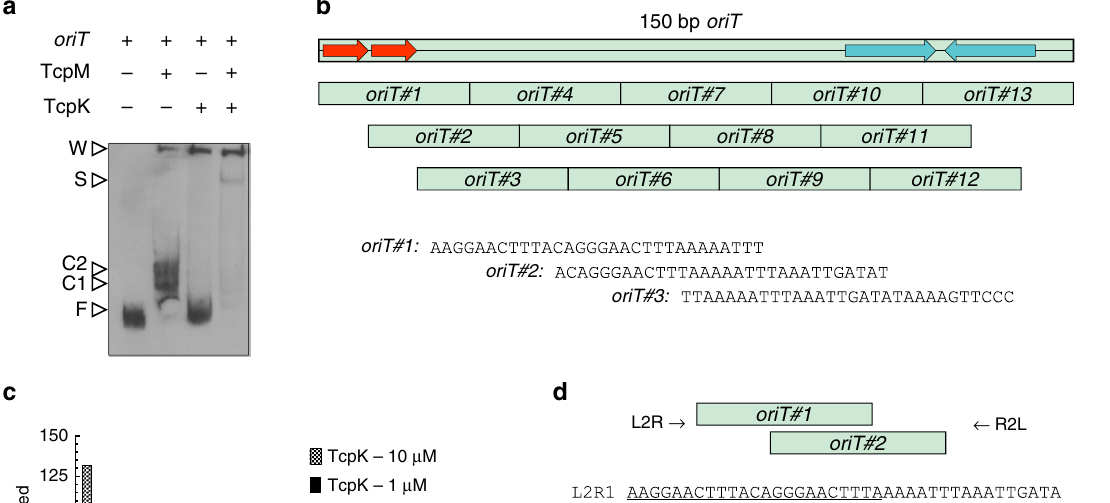
slight bend of the DNA molecule, which is also re fl ected by the large deviation from standard values of the inclination angles at the center of the molecules (Supplementary Table 3).